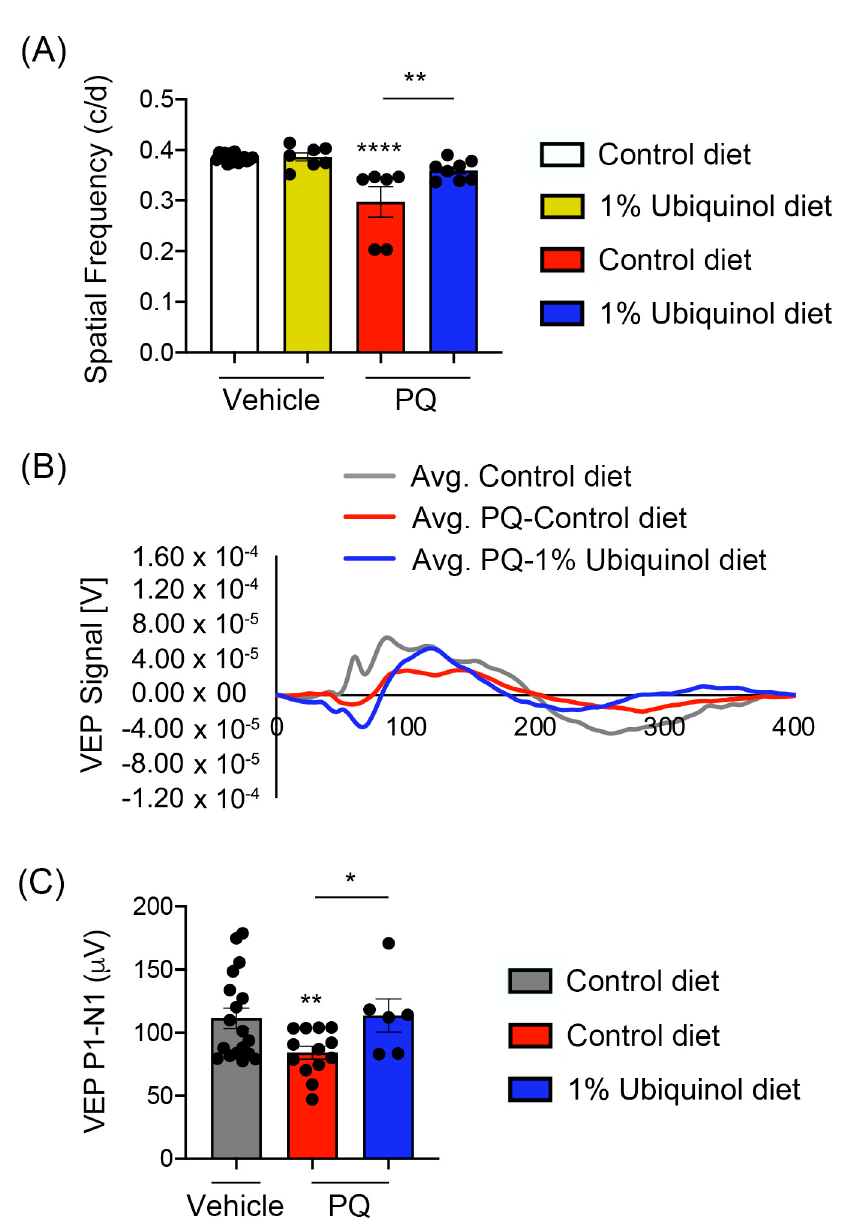
Figure 8. Effect of ubiquinol on visual function in PQ-induced C57BL/6J mice. ( A ) Visual function